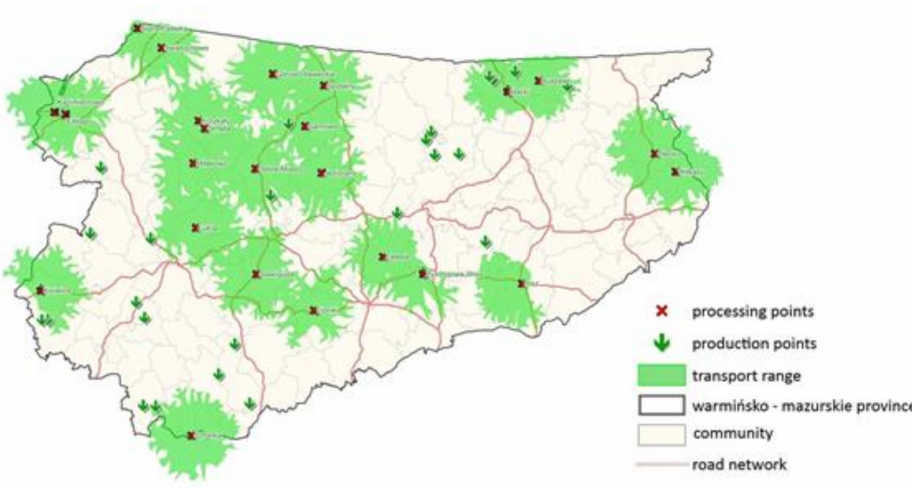
Figure 5. Distribution of biomass producers and processing companies in the Region of Warmia and Mazury. Source: